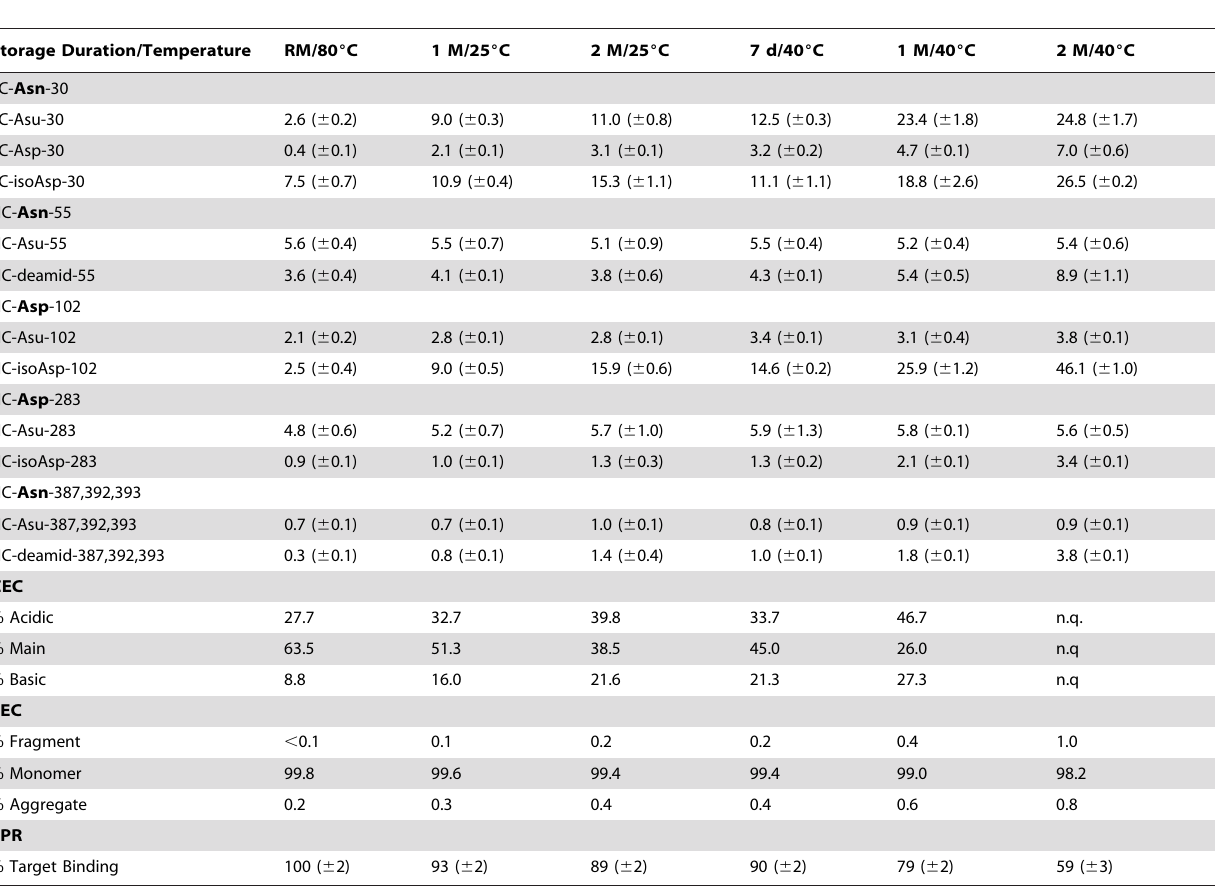
Table 2. Assessment of HER2 Asn deamidation and Asp isomerization using accelerated degradation conditions and quantitative UPLC-MS (Procedure